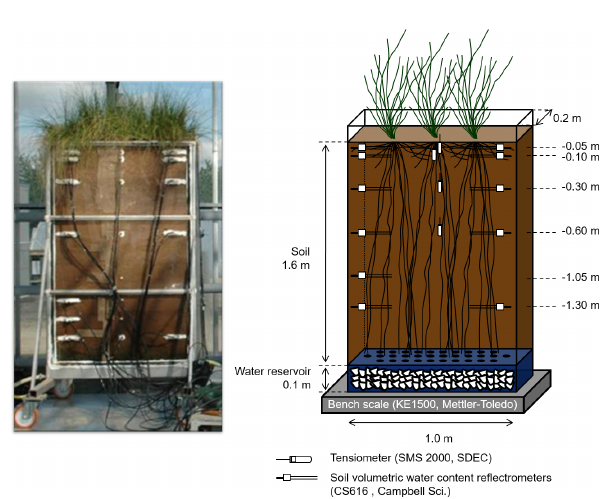
Figure A1. Soil macro-rhizotron experimental setup with tall fescue cover.